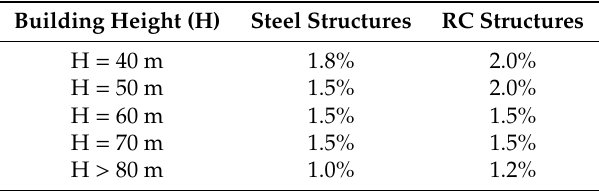
Table 4. Values of structural damping ratio, ζ str , in ISO 4354.